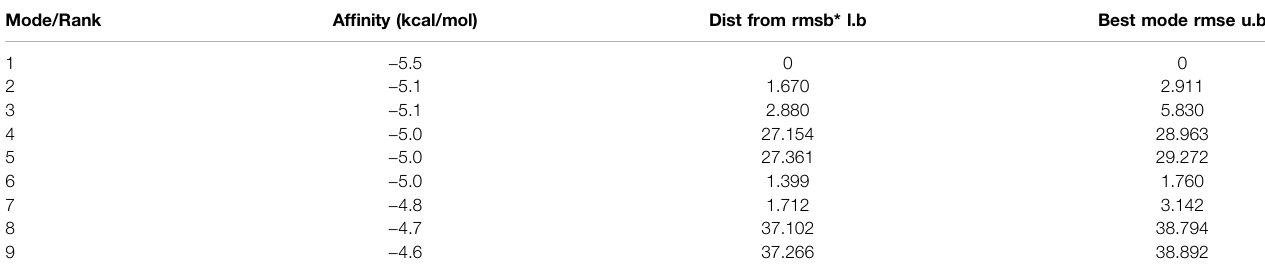
TABLE 2 | MOE scores of hP2X4 protein and gallic acid (kcal/mol). Mode/Rank Af fi nity (kcal/mol) Dist from rmsb* l.b